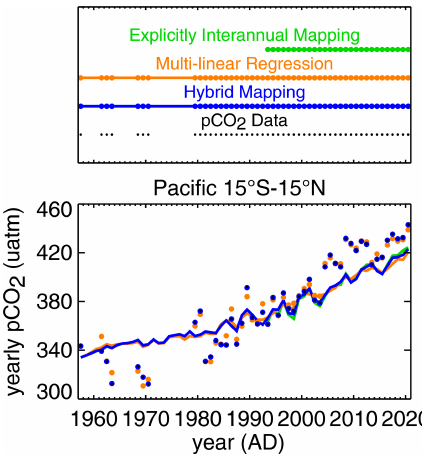
Figure 7. Estimated p CO 2 in the tropical Pacific, averaged spa- tially and over calendar years. The coloured lines give full re- gional averages from the explicitly interannual mapping (green), the multi-linear regression (orange), and the hybrid mapping (blue). The coloured dots are from the same estimates but averaged only over the pixels and time steps covered by p CO 2 data in the respec- tive year. The smaller black dots give the corresponding averages over the data. We note that the green, blue, and black dots are not visible individually because they are almost exactly located on top of each other, indicating that the model–data residuals of the explic- itly interannual and hybrid mappings are very small. The differences between dots and lines reflect the bias of the incompletely sampled average compared to the full regional average, which the mapping algorithm is trying to